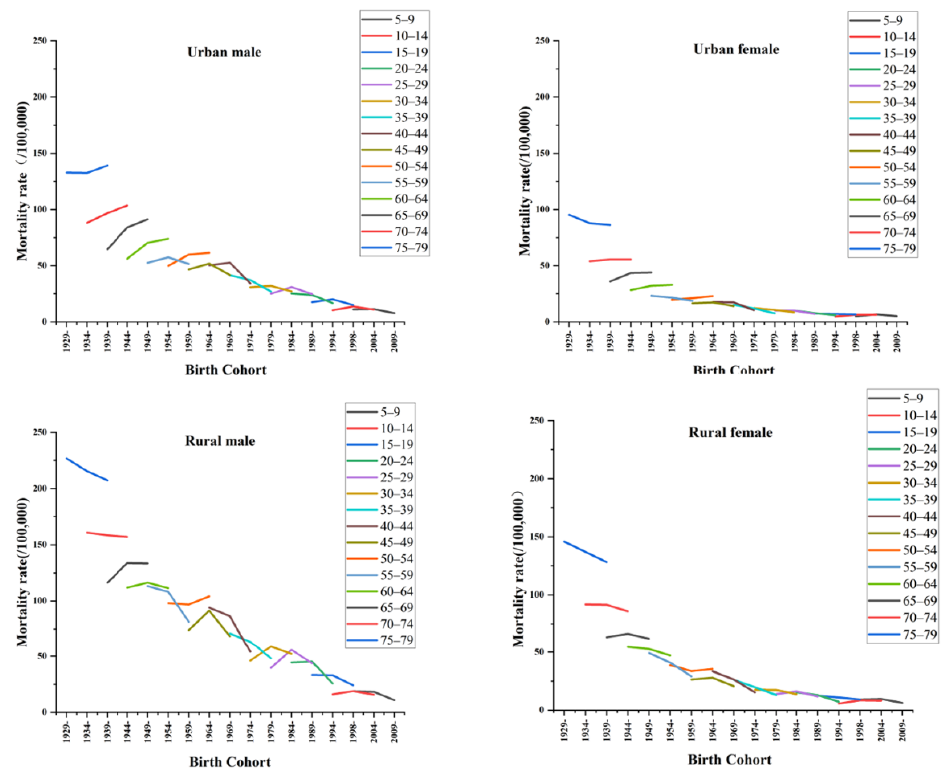
Figure 3. The trends of injury and poisoning mortality in China by gender and region with birth cohorts. Note: Birth cohort = period-age, the earlier the cohort (1929–1933) indicates that the current population is elderly, and the later the cohort (2009–2013) indicates that the current population is adolescent. Each colored line segment represents 15-year mortality trends for different birth cohorts.